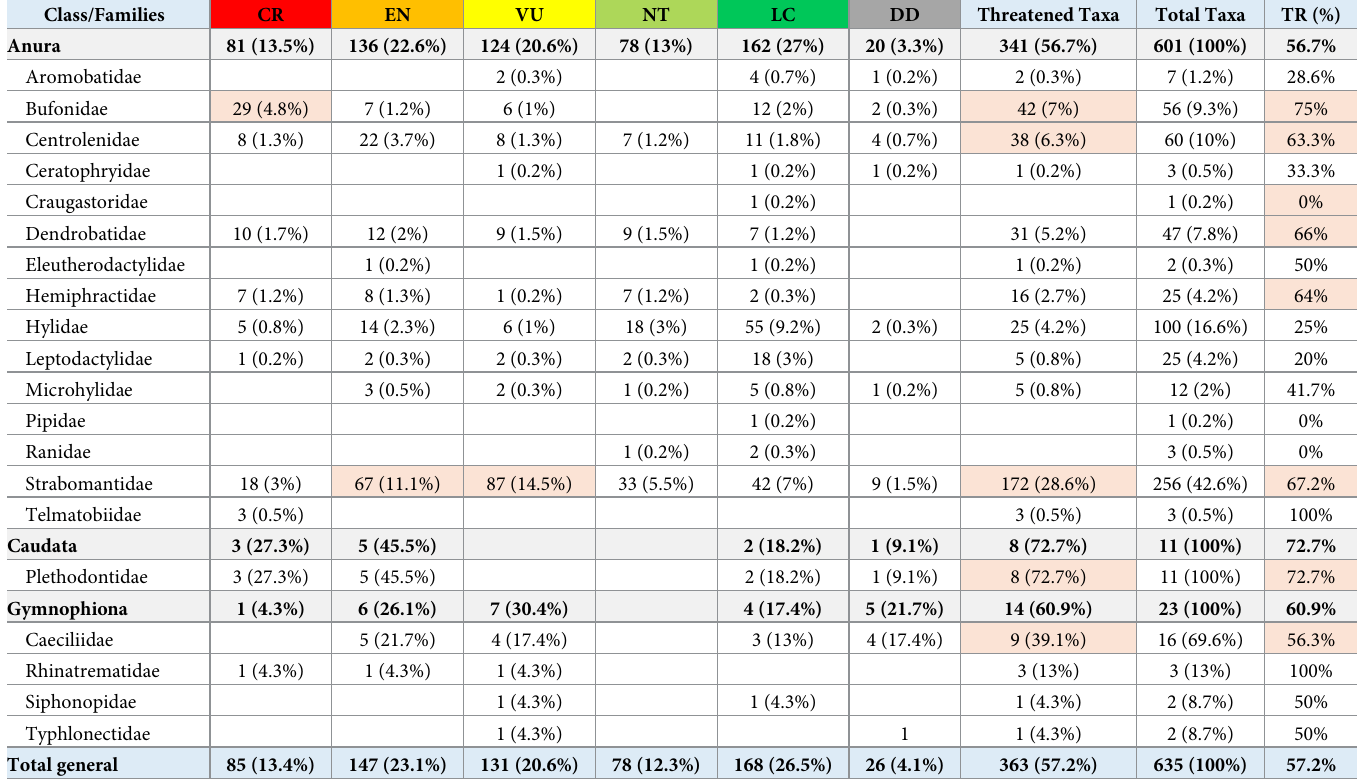
Table 3. Species (percentage) and threat categories, assessed by family in Ecuadorian